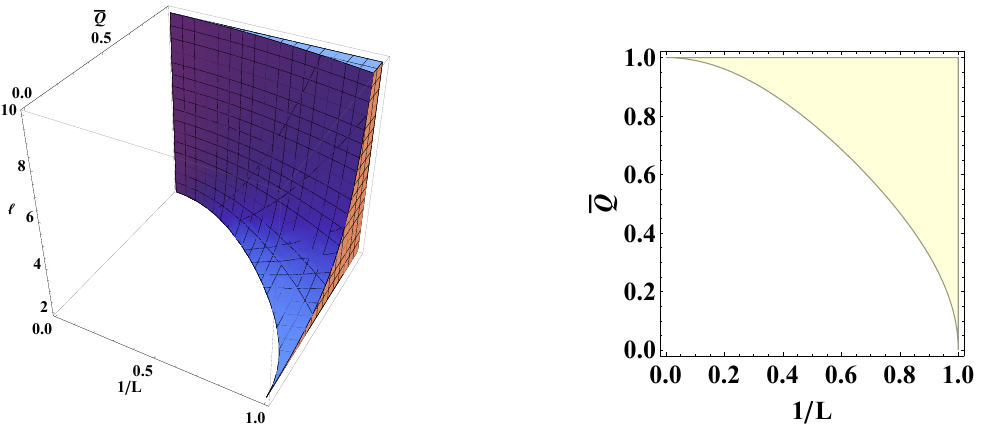
Figure 3 . The unstable regions of the de Sitter Reissner-Nordstrom black hole. The left panel shows the unstable region in ( L; Q; ‘ ) space. The right panel shows the unstable region with ‘ = 2 in light